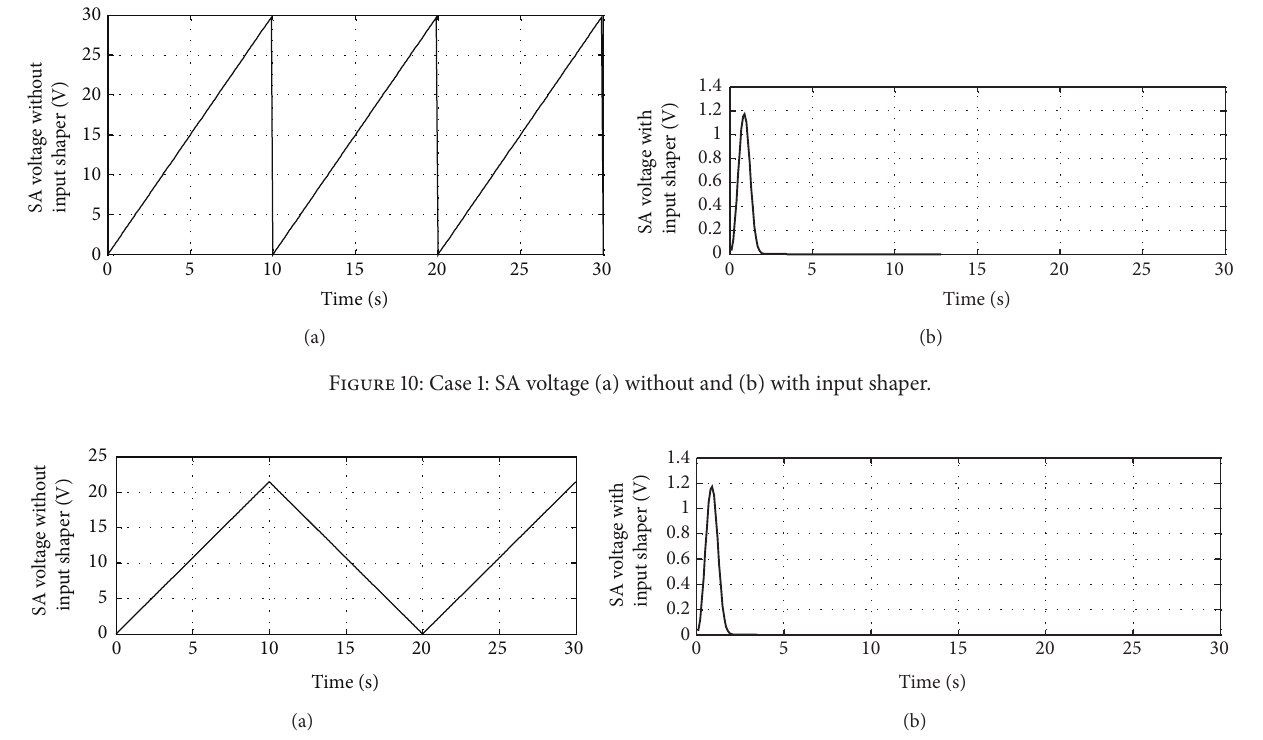
Figure 11: Case 2: SA voltage (a) without and (b) with input shaper.